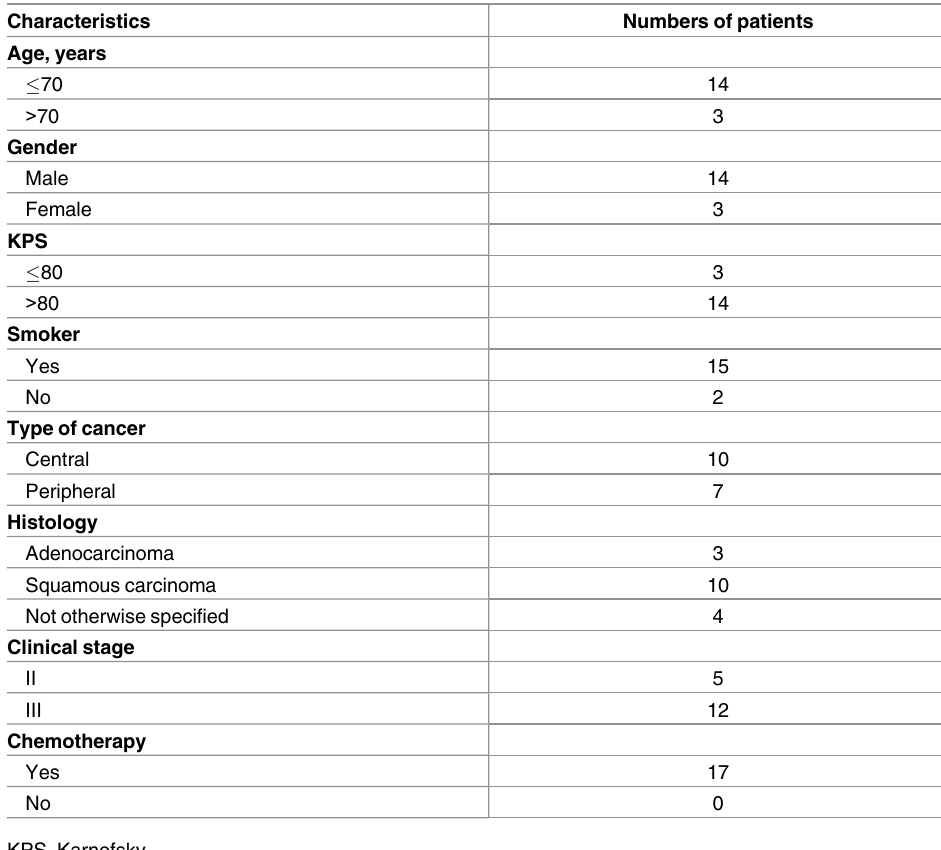
Table 1. Patient